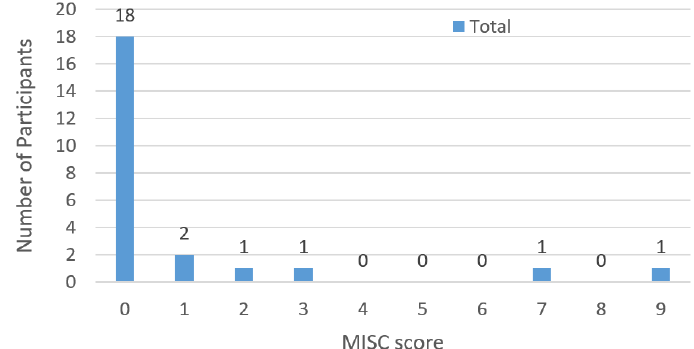
Figure 11. Distribution of the participants according to their motion sickness state based on MISC score.